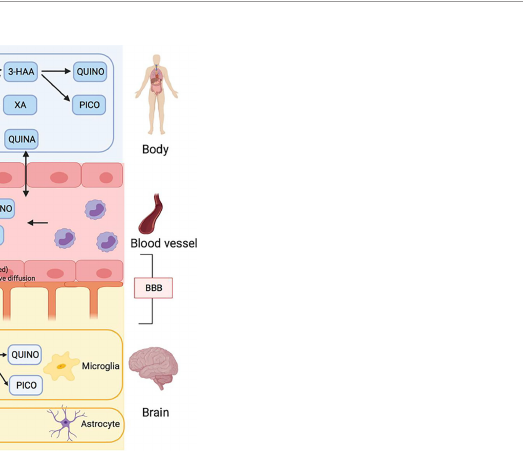
FIGURE 1 | Kynurenine metabolites and the blood brain barrier (BBB) Skorobogatov et al. Tryptophan (TRP) and kynurenine (KYN), and to a lesser degree 3-hydrox kynurenine (3-HK) are actively transported into the brain over LAT1 transporters. Downstream metabolites of the kynurenine pathway (KP), like quinolinic acid (QUINO) and kynurenic acid (KA), cannot make use of these transporters, but (probably limited) passive diffusion of these metabolites over the BBB is possible. Anthranilic acid AA and 3-hydroxy anthranilic acid (not shown in fi gure) may equally pass the blood brain barrier through passive diffusion, much like QUINO. In the brain, microglia are responsible for the production of metabolites 3-HK and QUINO, whereas astrocytes produce KA. Peripheral production of these KP metabolites is done by blood immune cells, such as blood monocytes (PBMC) and other organs, including liver and kidney. The gut microbiome, which plays a role in psychiatric illness through the gut-brain axis, also affects KP